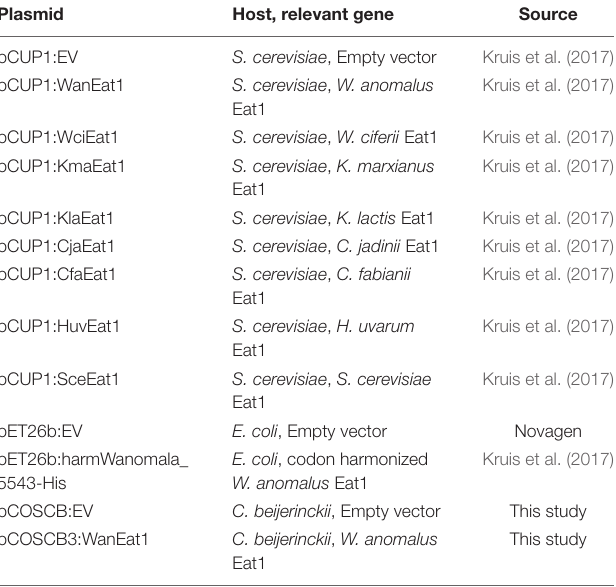
TABLE 2 | Plasmids used in this